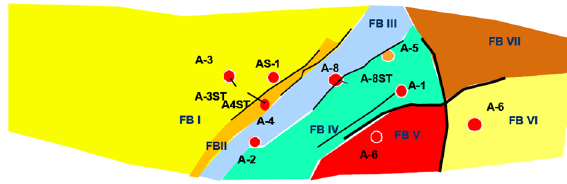
Fig. 2 Schematic of field S including the EPS development